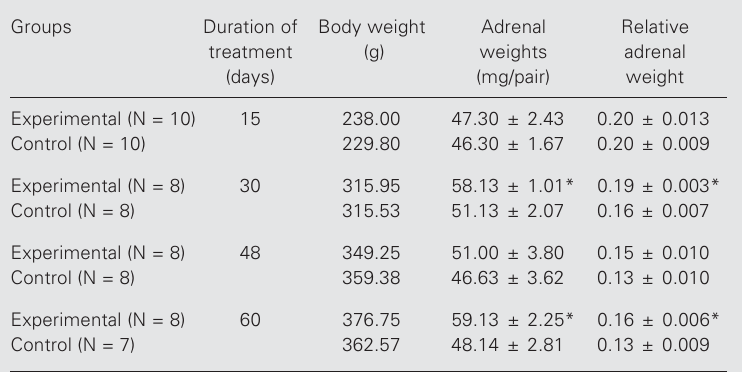
Table 2. Effect of hyperprolactinemia induced by domperidone on adrenal weights of young rats.